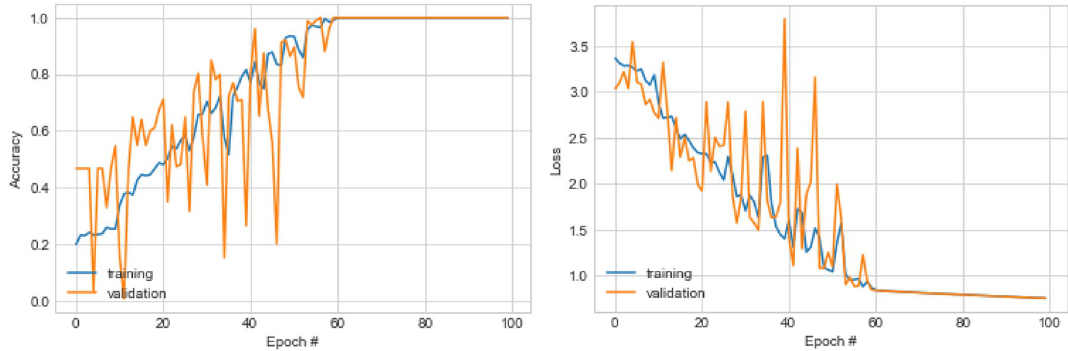
Figure 12. Plot of the accuracy and loss values for the training of the Top-1 architecture optimized using EOSA-NAS model, which represents the overall best performing architecture after hundred (100) training epoch.